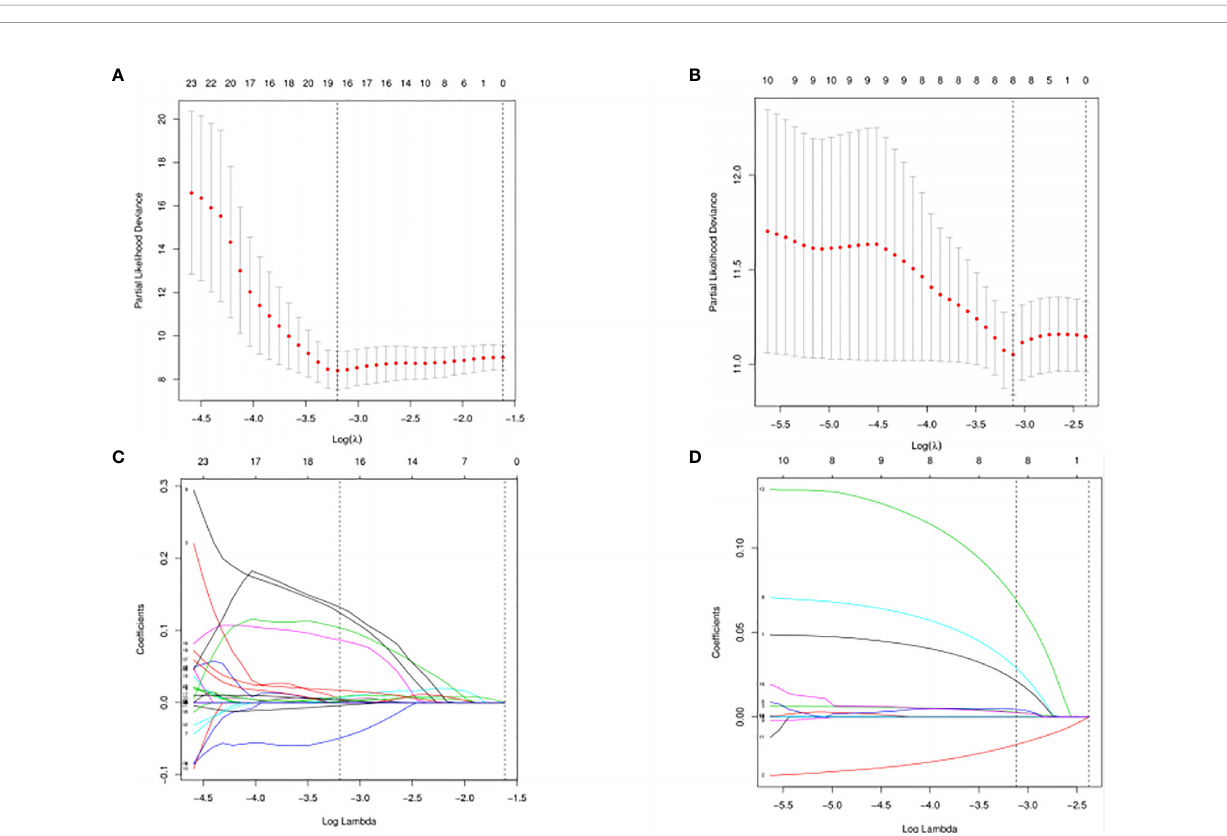
FIGURE 3 | Cross-validated and lassopath of LASSO COX. HPV+ group: (A) and (C) ; HPV- group: (B) and (D) . 18 variables were selected according to the lmin; log(lmin) = − 3:20; (C) and (D) HPV- group, 8 variables were selected according to the lmin; log(lmin) = −